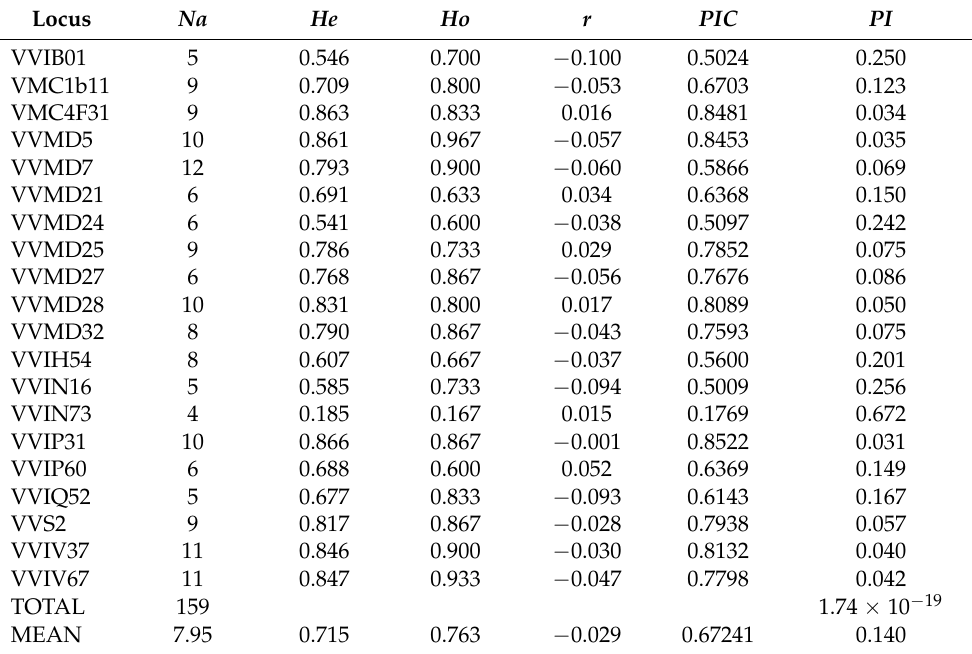
Table 2. Characterization of 20 microsatellite markers in the 30 genotypes.